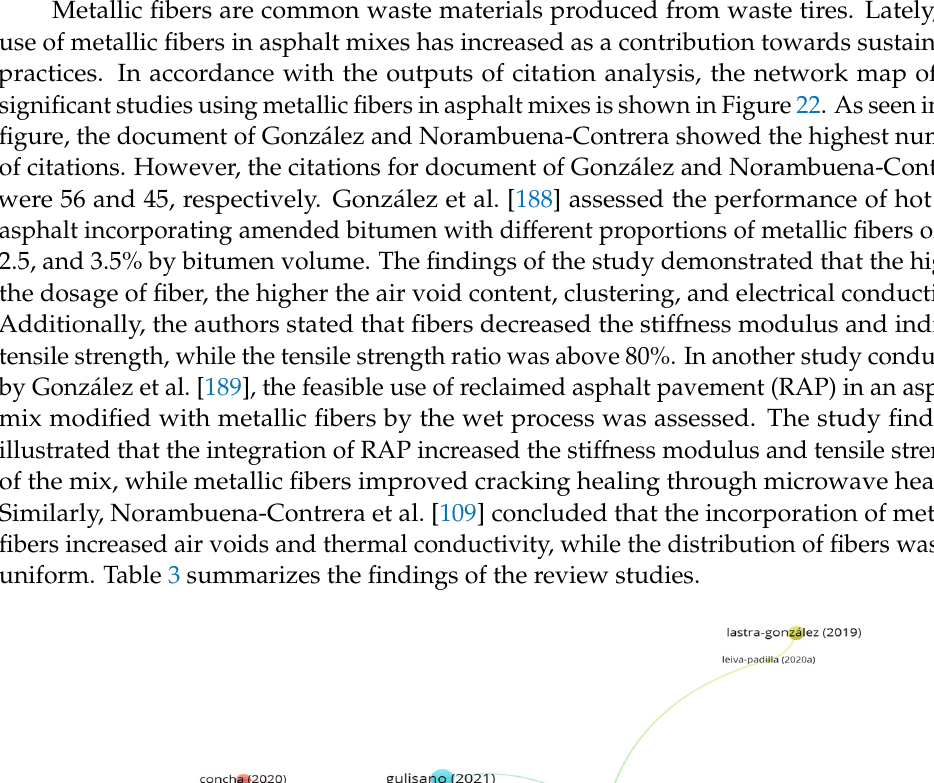
Figure 21. Network visualization of tire textile fibers.